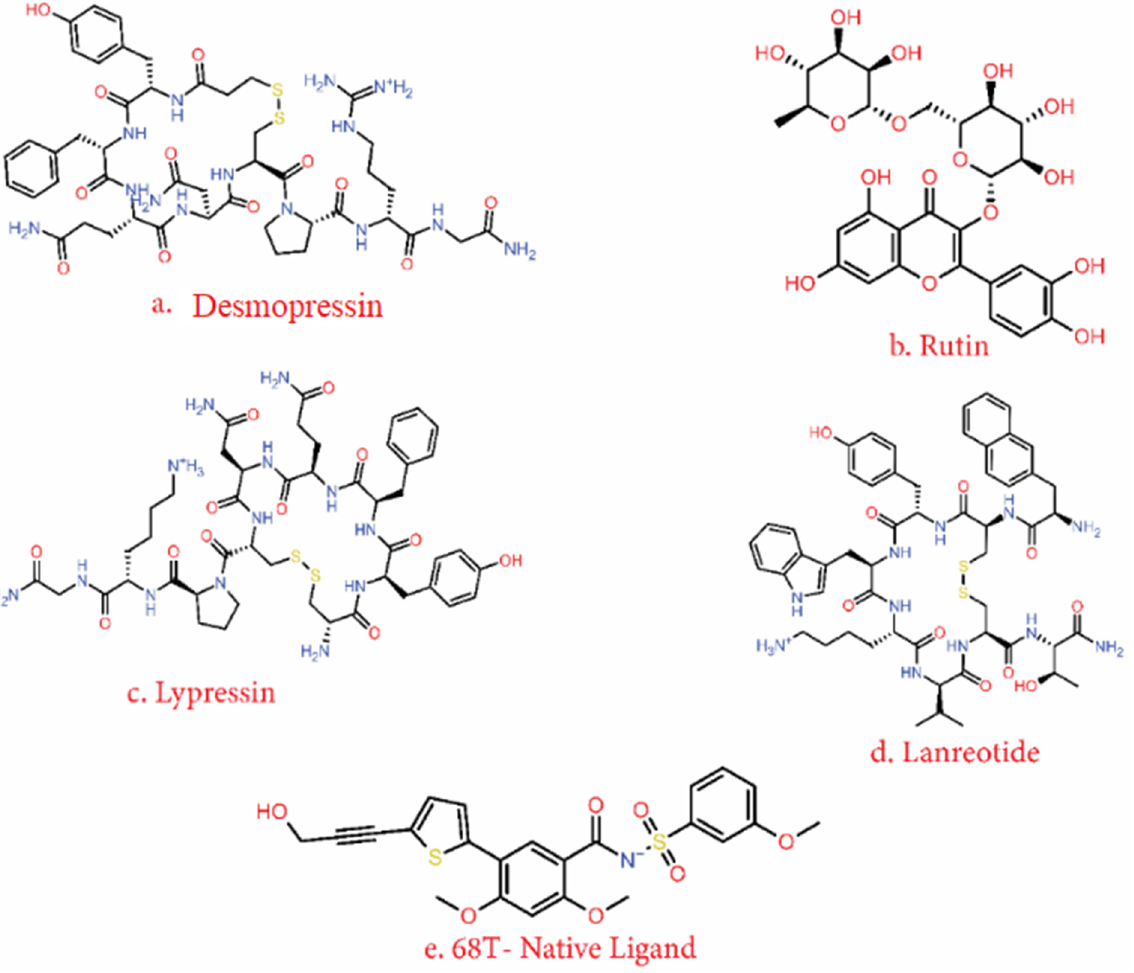
Figure 3. Top four approved drug compounds selected—( a ) desmopressin, ( b ) rutin, ( c ) lypressin, and ( d ) lanreotide—that showed the minimum MM/GBSA free energies in structure-based screening of 27 potential hits; ( e ) 68T is the control ligand co-crystallised with the protein structure, used as a reference compound. Table 2. Binding scores of the top four screened drug compounds against DENV RdRp.